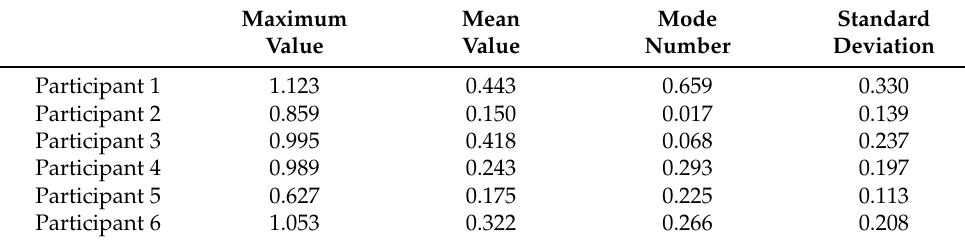
Figure 12. Experiments of Hybrid ADRC on six participants. ( a ) Step response experiments. ( b ) Sinu- soidal response experiments. Table 2. Force tracking error analysis of step response experiments on six participants.